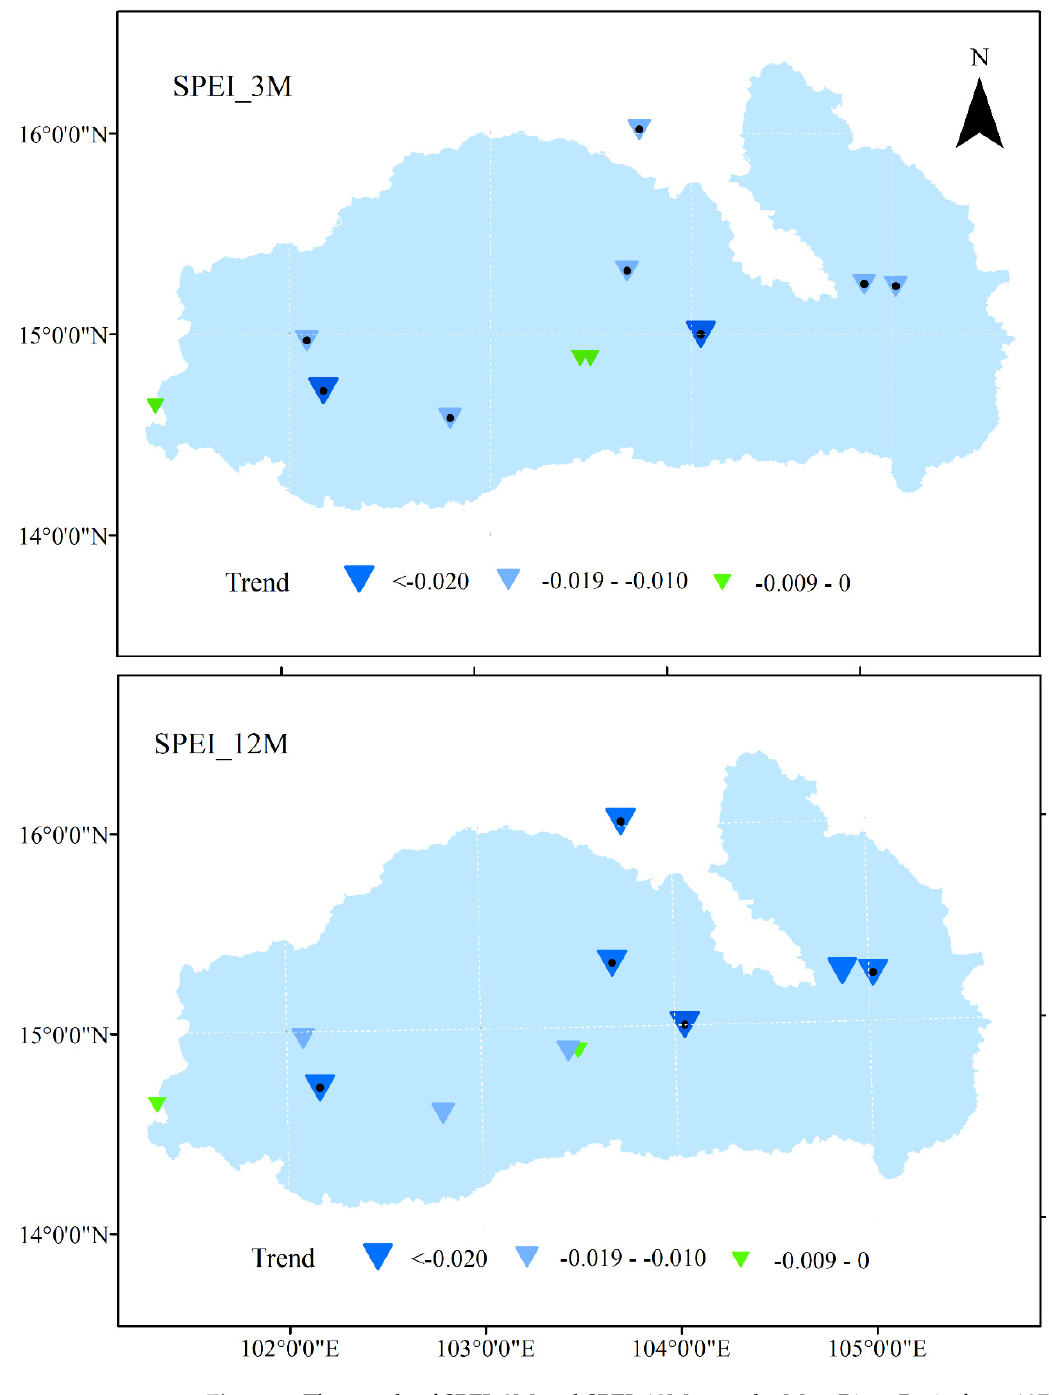
Figure 3. The trends of SPEI_3M and SPEI_12M over the Mun River Basin from 1971 to 2016. The inverted triangles show decreasing trends, and the points show the differences are significant at the 95% confidence interval level based on the Pettitt test.